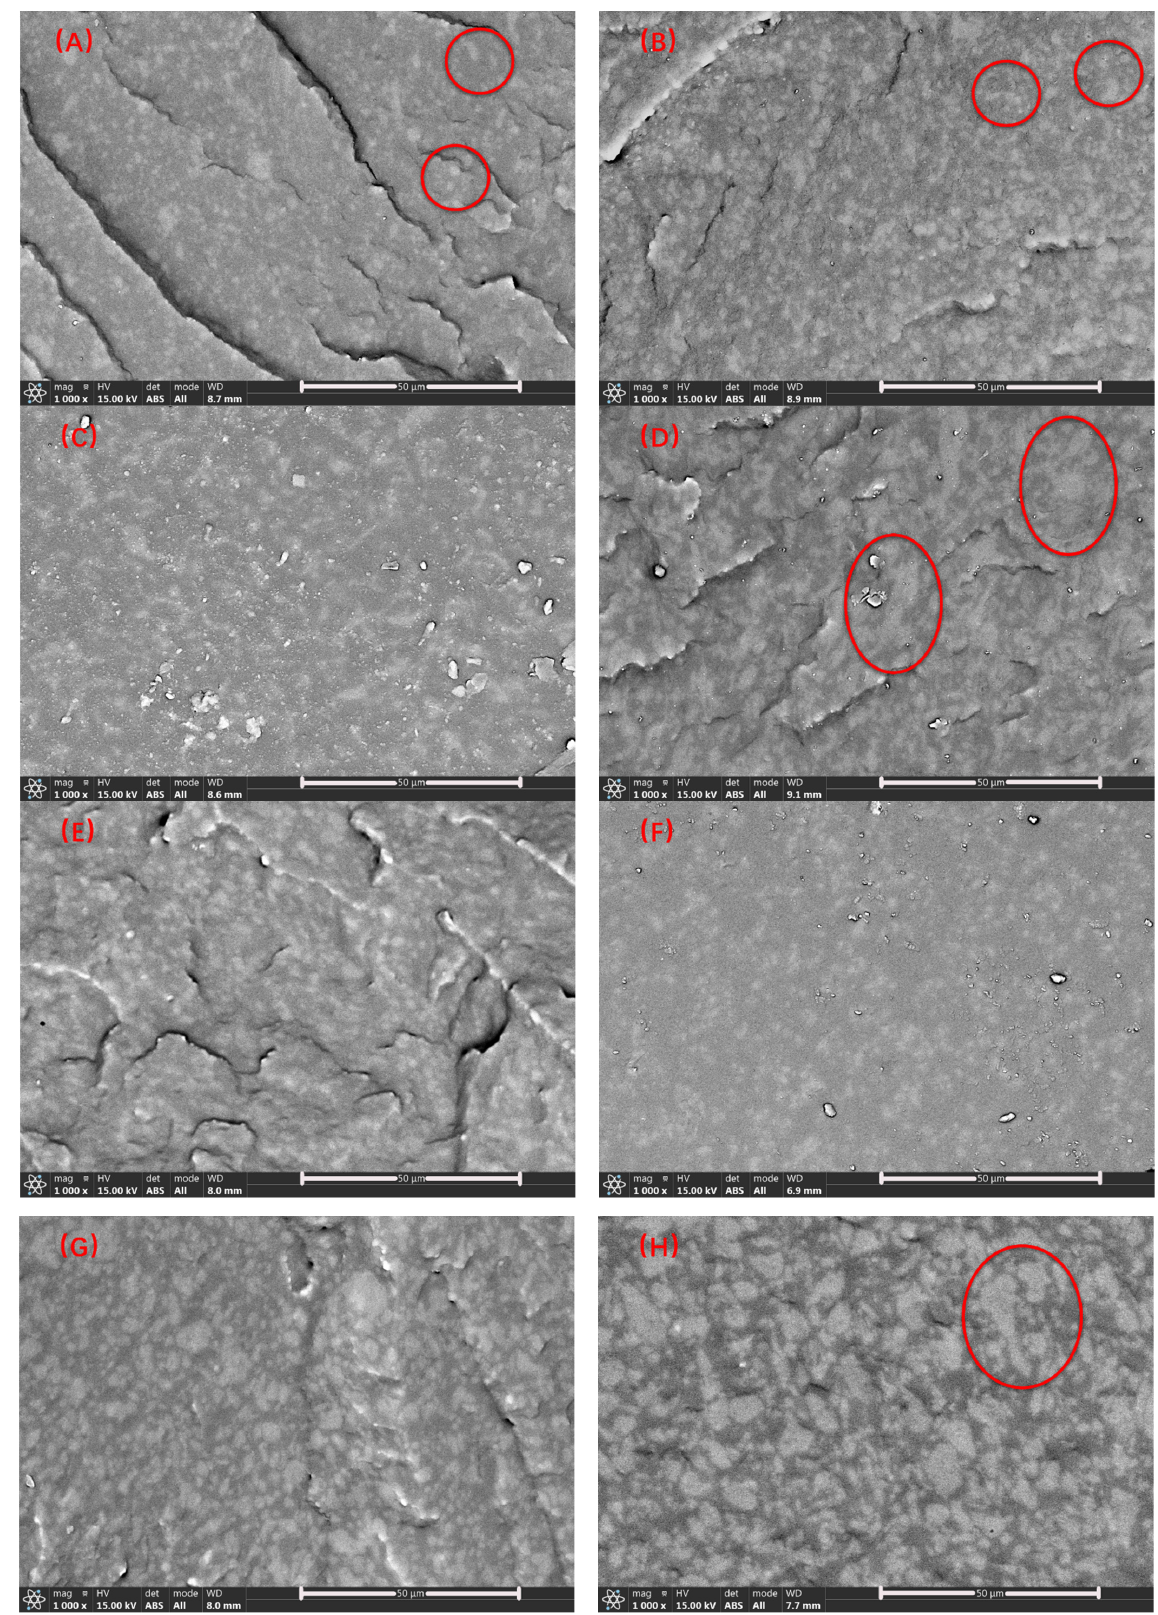
Figure 6. BSE diagrams of TPSiV, ( A – H ) correspond to samples 1–8, respectively.